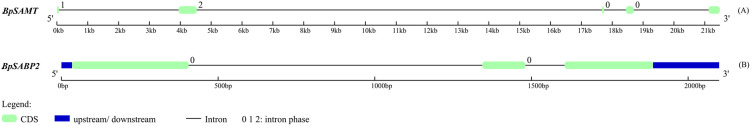
Structural features of B. pendula SAMT and SABP2 genes.Exons are represented by round-corner rectangles, while the line between two exons represents an intron. Intron phases are represented by the numbers above the line. The intron phases are likely to assist in exon shuffling, recombination fusion, and protein domain exchange [45, 46].